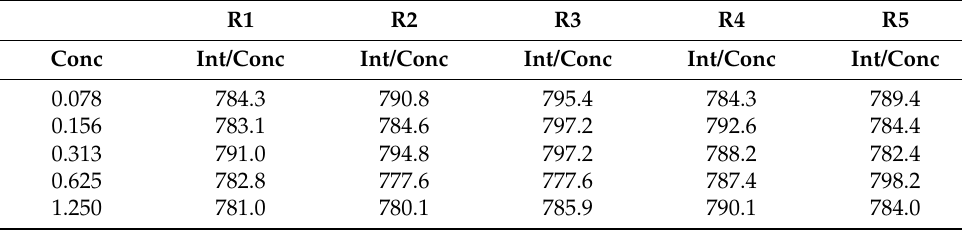
Table 6. Linearity of the fluorometric method by ANOVA test of the response factor of the calibra- tion